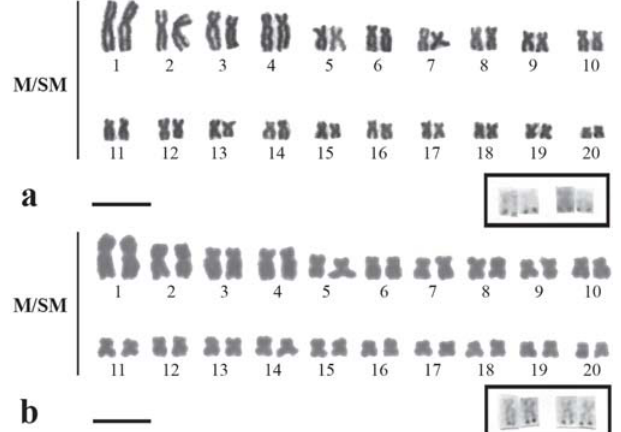
Fig. 2. Giemsa-stained karyotypes of Hoplias malabaricus from Contas River basin (a) and Itapicuru River basin (b): The NOR-bearing pairs are shown in detail. Bar = 10µ.